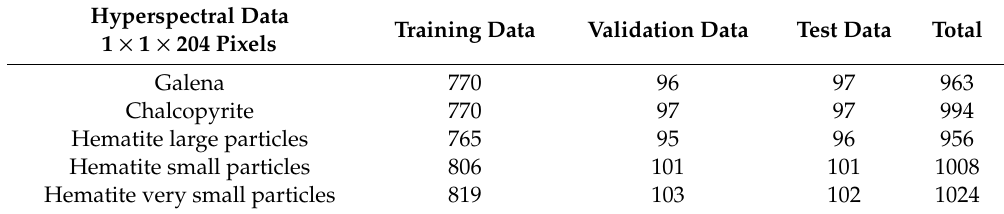
Table 4. Hyperspectral data set.